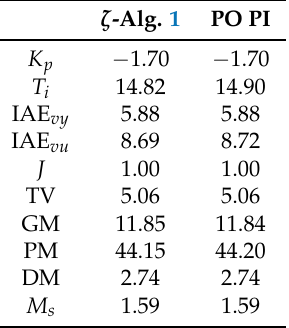
Table 14. Example 6. The corresponding controller parameter, indices and margins are given for prescribed robustness M s = 1.59. ζ -PRC + Algorithm